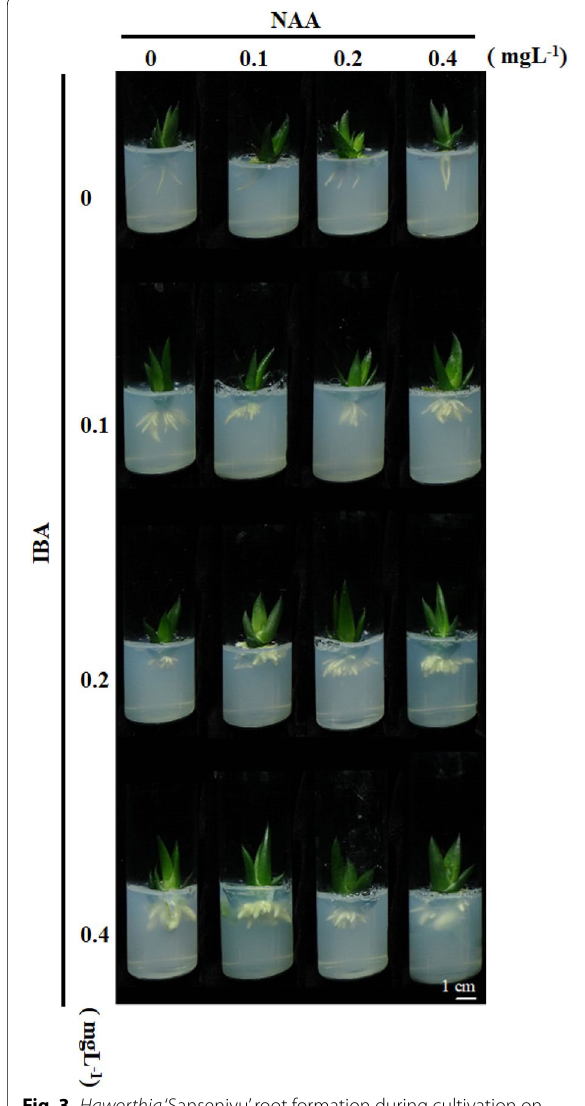
Fig. 3 Haworthia ‘Sansenjyu’ root formation during cultivation on different concentrations of NAA and IBA for 4 weeks. MS medium contained combinations of 0, 0.1, 0.2, or 0.4 mg L − 1 NAA and 0, 0.1, 0.2, or 0.4 mg L − 1 IBA